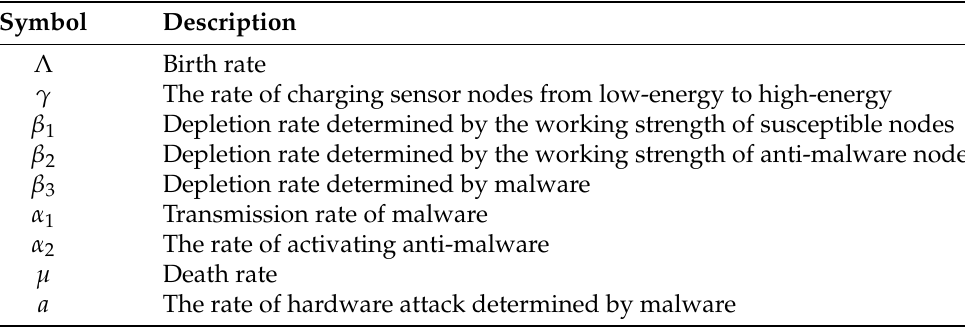
Table 4. Epidemiological coefficients of the